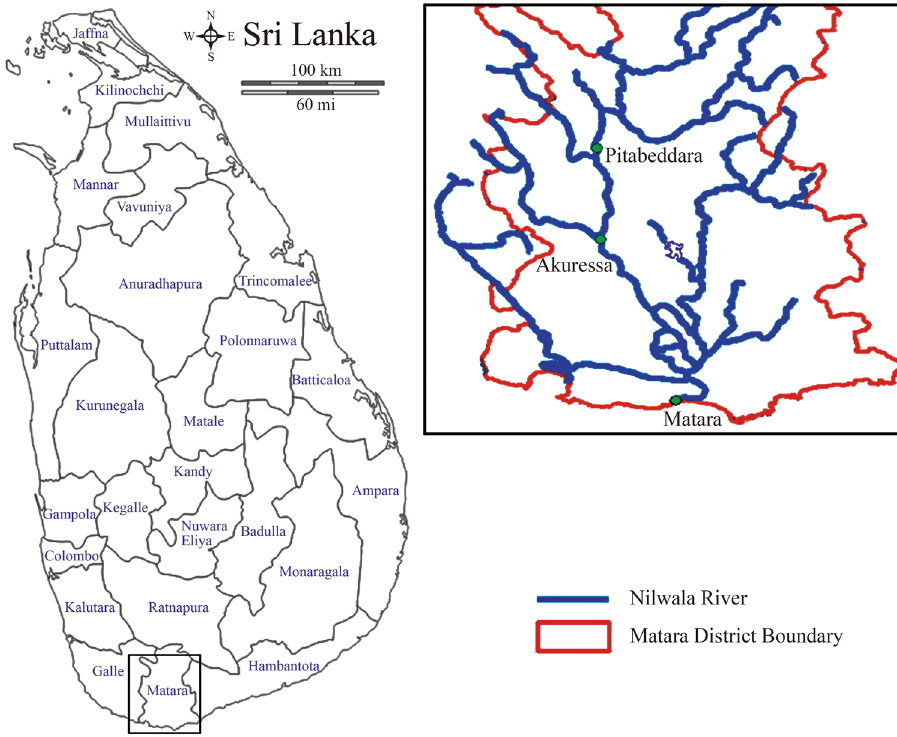
Fig. 1 The location of Akuressa in Matara District